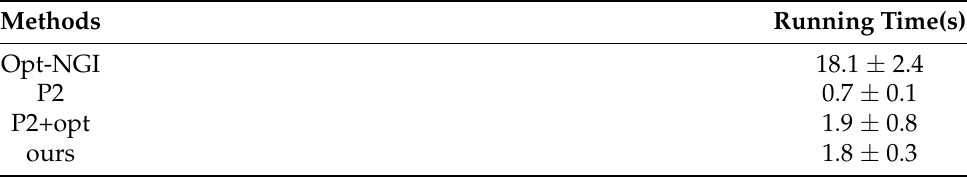
Table 2. The running time results of three methods. The proposed method has comparable efficiency with